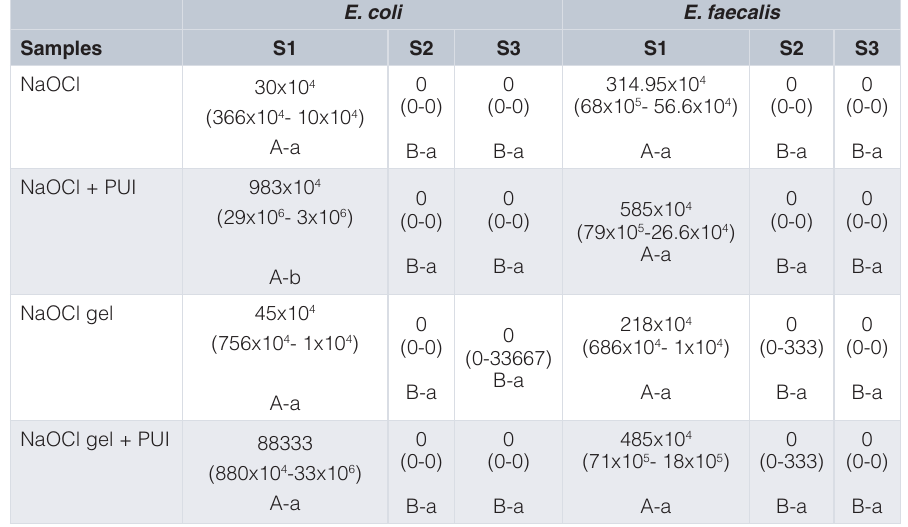
*Different letters indicate statistically significant differences (p<0.05). Uppercase letters indicate difference in rows (Friedman test; intra-groups) and lowercase letters indicate difference in columns (Kruskal-Wallis test; inter- groups).